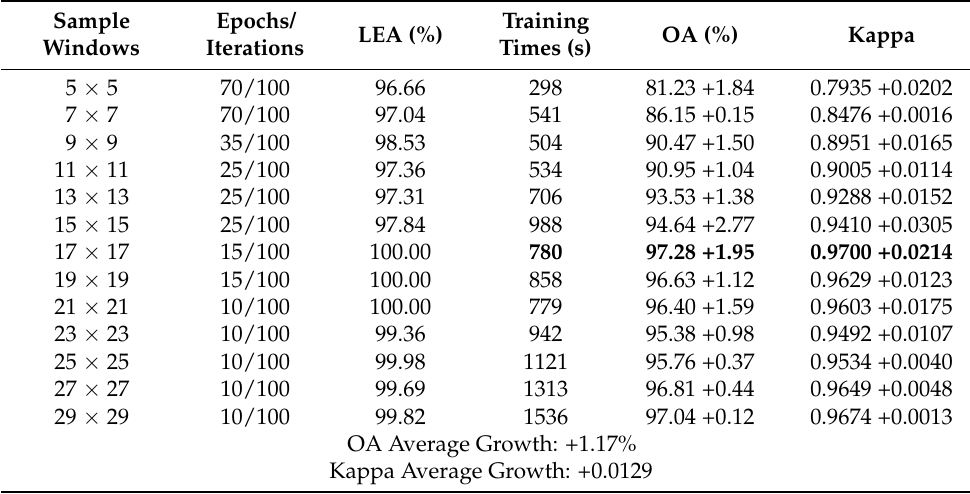
Table 5. Classification accuracy of Channel